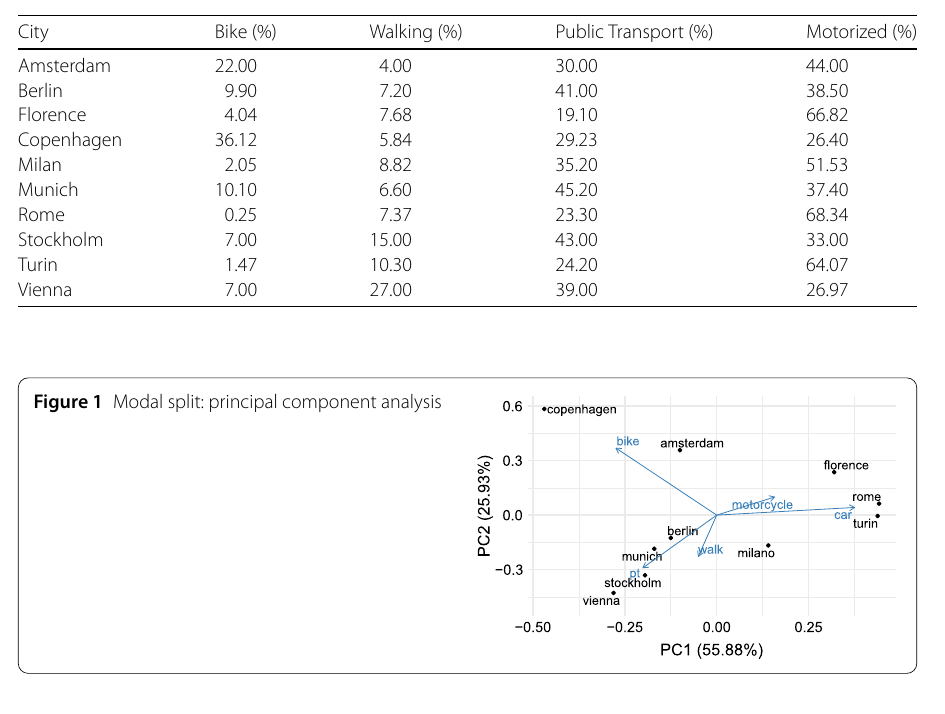
of cities: one in which motorised modes dominate, one in which public transport (PT) and walking are more important, and one in which people move prevalently by